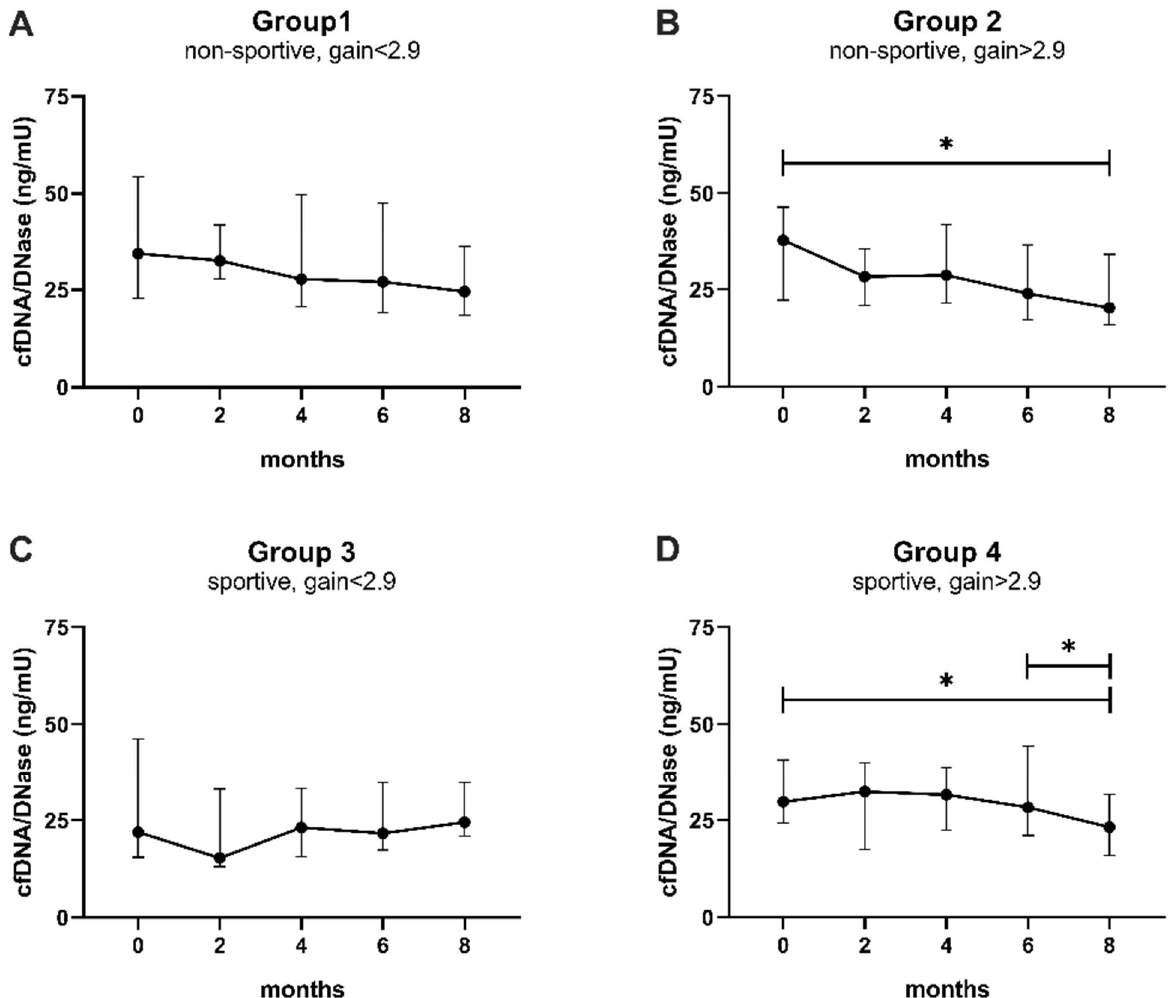
Figure 5. The capacity to balance cfDNA is increased in response to performance gain. ( A ) Non- sportive, gain < 2.9, ( B ) non-sportive, gain > 2.9, ( C ) sportive, gain < 2.9, ( D ) sportive, gain > 2.9. CfDNA levels were divided by DNase activity and compared between baseline and 2 months, baseline and 8 months, and 6 and 8 months by Wilcoxon matched-pairs signed rank tests, which were corrected using the Bonferroni–Holm method (Table A5). Data are presented as median ± IQR. * p < 0.05, IQR interquartile range.